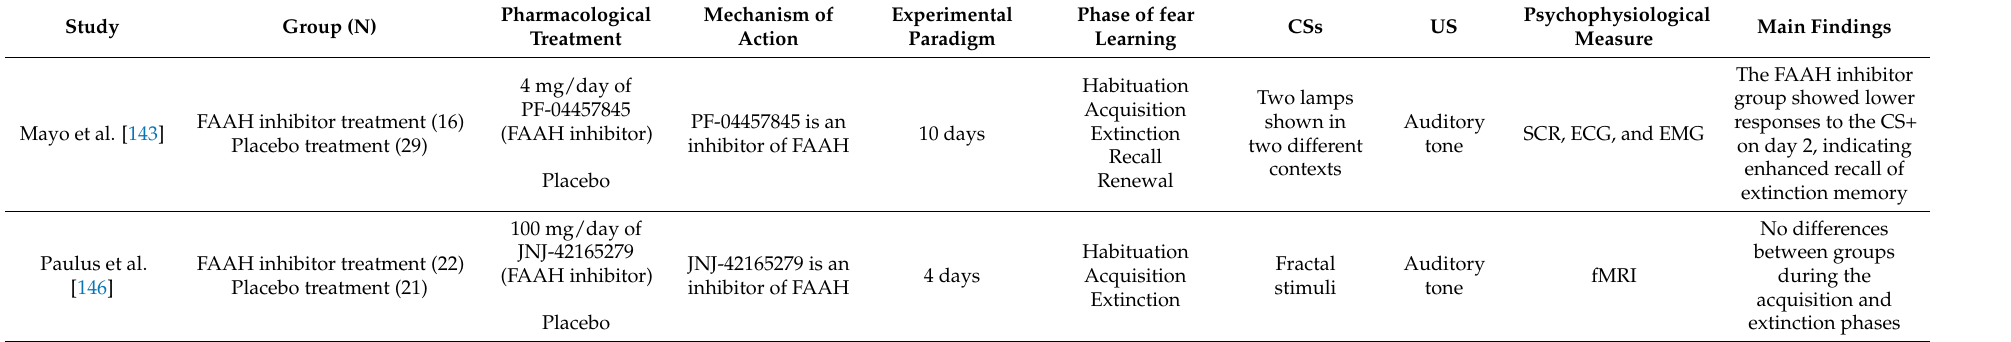
Table 3. Summary of findings in studies with AEA elevation by FAAH